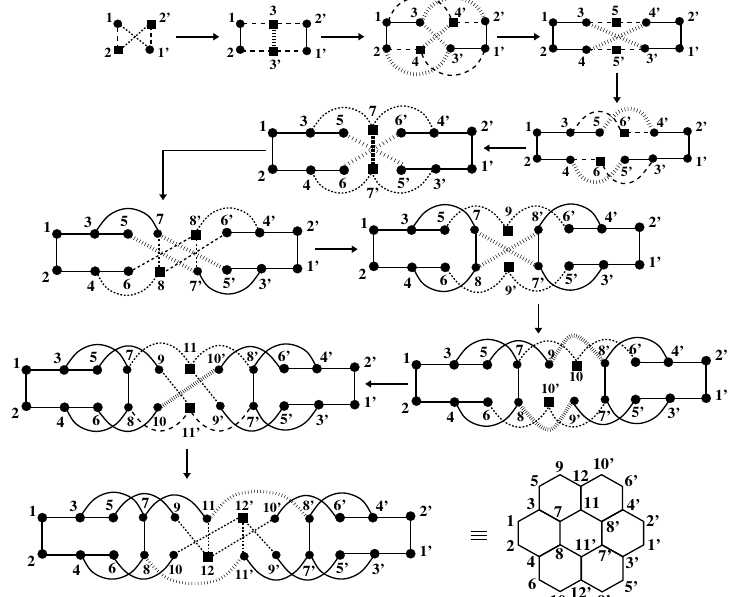
Figure 1. Construction of the coronene molecule in the infinite DMRG method starting from a small system (four sites). The number of connections between the new and the old sites at the intermediate steps are kept similar to that in the final system for higher accuracy. At every step of the algorithm, two new sites are added, one to the system block (L) and the other to the environment block (R). The sites in the L -block are denoted by unprimed numbers, while those in the R -block are denoted by primed numbers. The newly-added sites are denoted by filled squares ( (cid:4) ), while old sites are denoted by filled circles ( • ). Solid lines are bonds within a block. The broken lines denote the connections between • and (cid:4) . Bonds between the two blocks, as well as the bond between newly-added sites are denoted by hatched